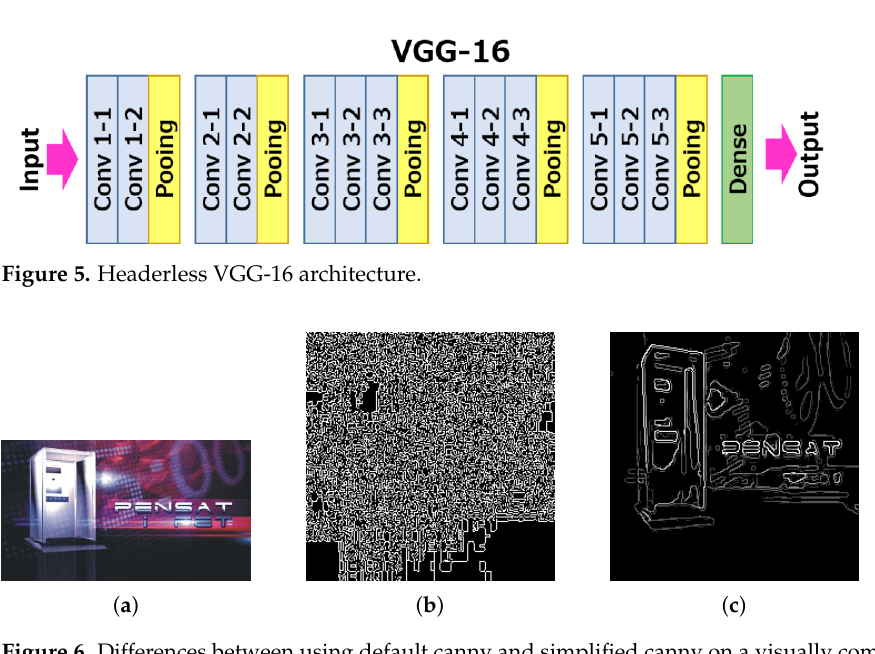
Figure 6. Differences between using default canny and simplified canny on a visually complex brand image: ( a ) original brand image; ( b ) default canny edge tracing; ( c ) K-Means clustering ( K = 4) + canny edge